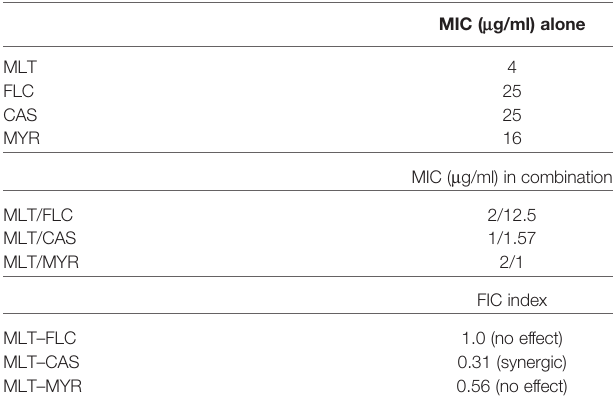
TABLE 2 | Synergism of miltefosine with fl uconazole, caspofungin and myriocin against Scedosporium aurantiacum .